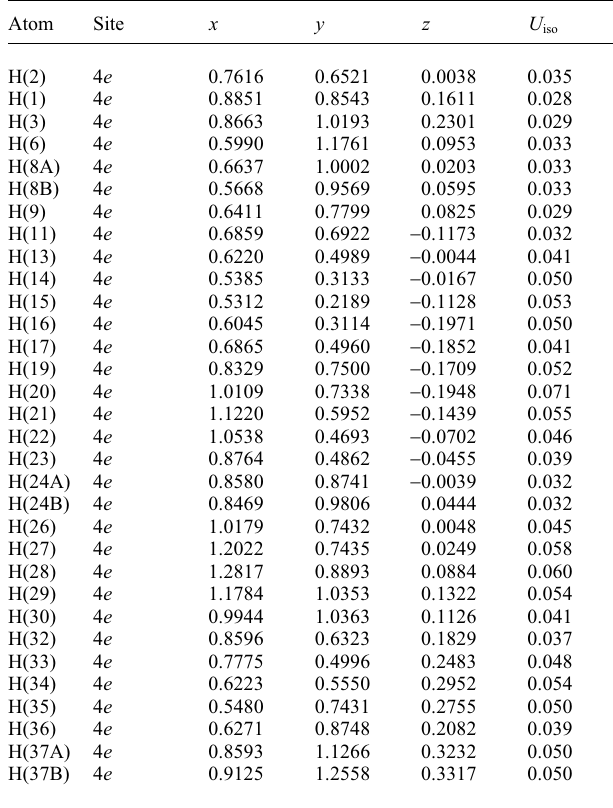
Table 2. Atomic coordinates and displacement parameters (in Å 2 )